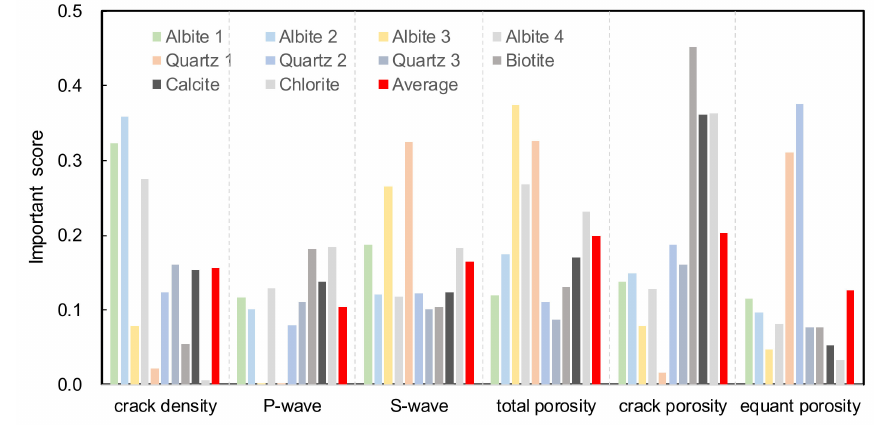
Figure 11. Important scores of each